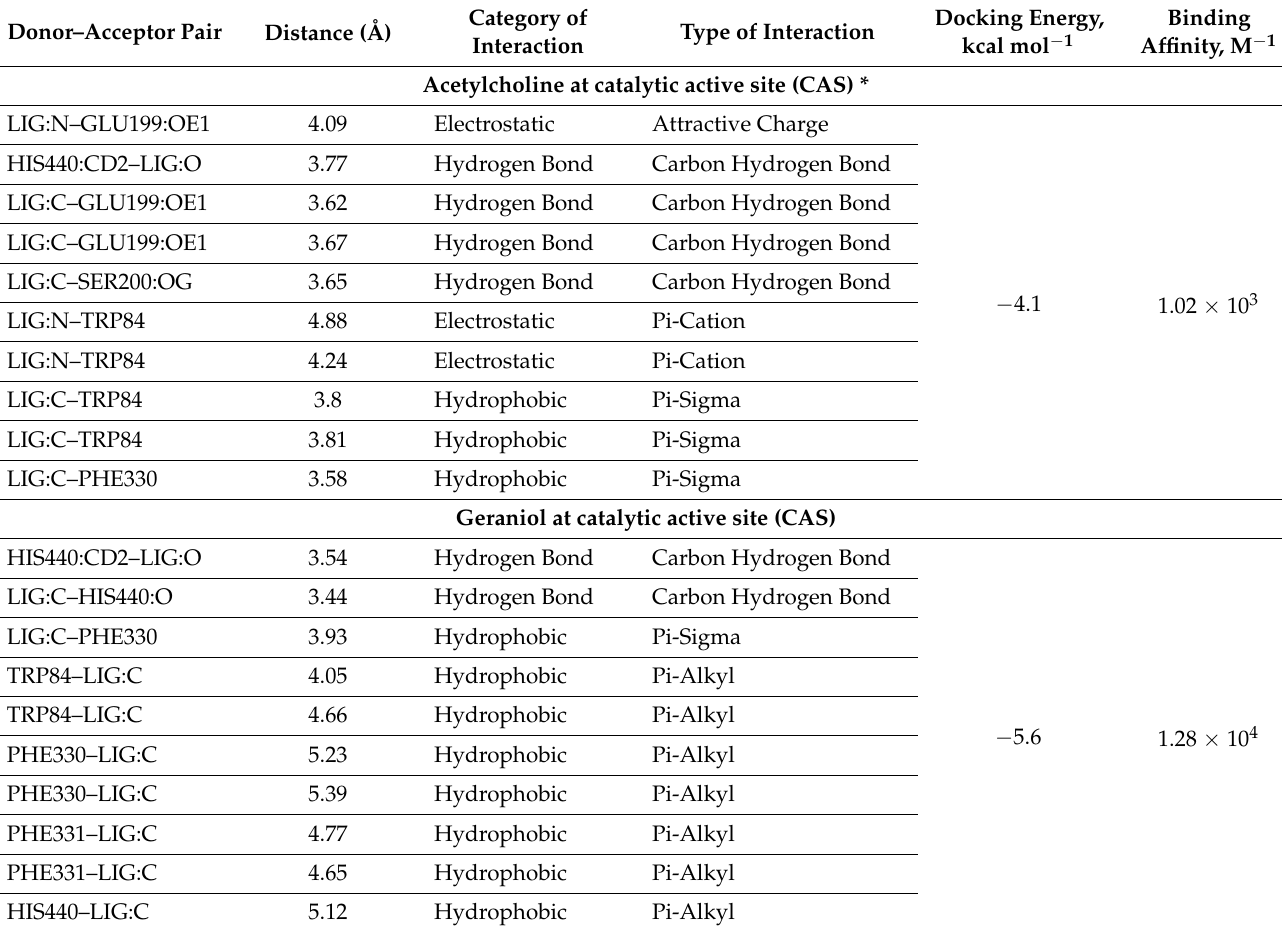
Table 2. Molecular docking parameters for the interaction of acetylcholinesterase (AChE) with geraniol and its respective control ligand (acetylcholine) at the catalytic active site (CAS) and peripheral anionic site (PAS). Donor–Acceptor Pair Distance (Å)